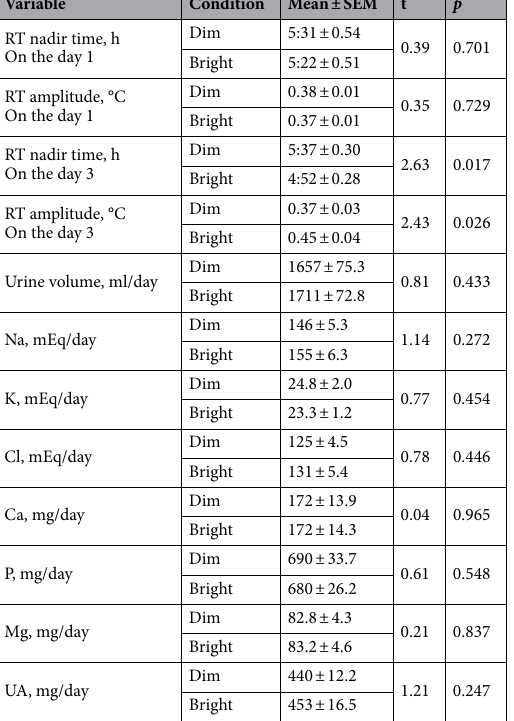
Table 1. Comparison of rectal temperature (RT) profile ( N = 19) and 24-h urinary excretion variables ( N = 16) between light condition groups. Ca calcium, Cl chloride, K potassium, Mg magnesium, Na sodium, P phosphorus, RT rectal temperature, UA uric acid. Statistical values are from paired t -tests.